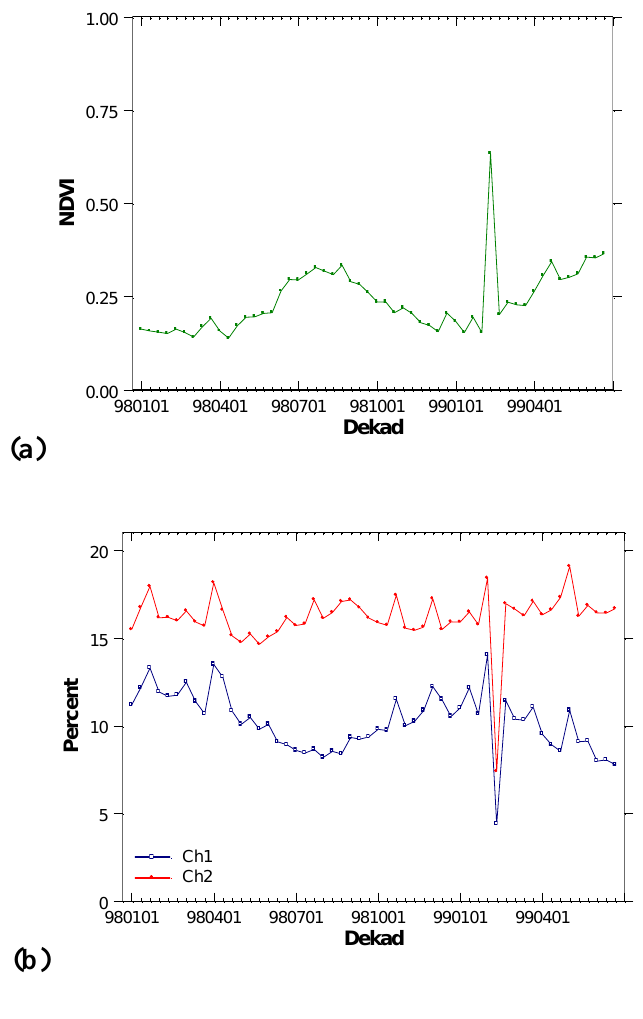
Figure 1. The Pathfinder 10-day composites averaged over the area with longitude range [110°E, 120°E] and latitude [20°S, 30°S] from January 1998 to June 1999. (a) NDVI, (b) AVHRR Channel 1 and Channel 2 reflectance in percent.